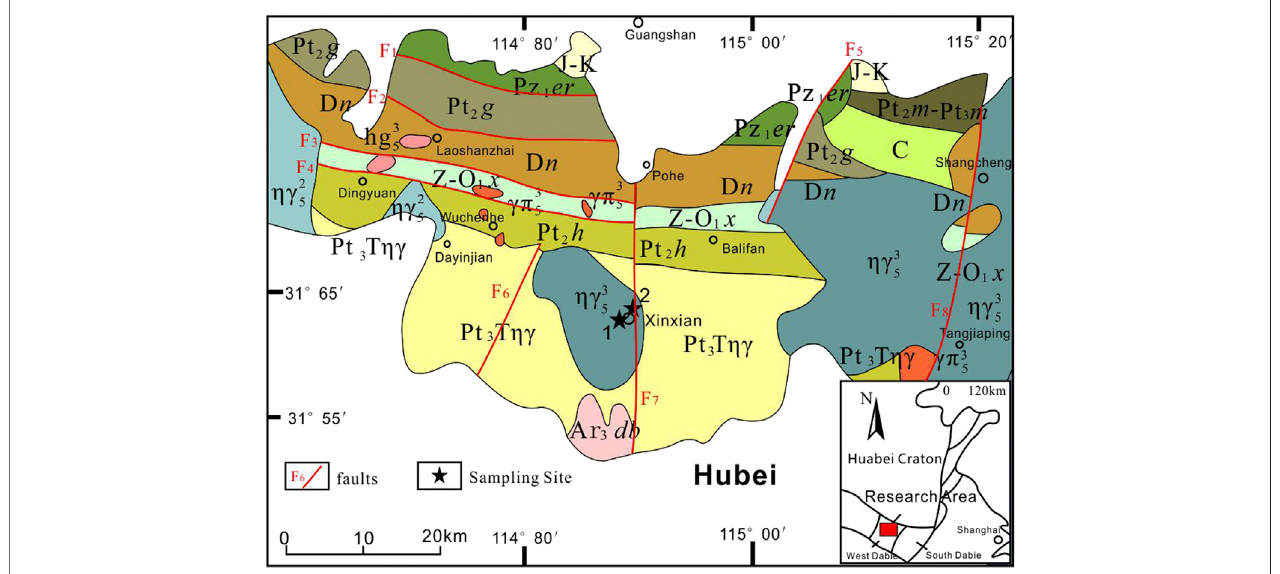
FIGURE1| GeologicalmapoftheXinxianareaintheDabieorogenicbelt(modi fi edafterKun-guangetal.,2009;Dong-xingetal.,2011).J-K,Jurassic – Cretaceous volcanic rocks and volcano-sedimentary rocks; Kc, Lower Cretaceous Chenpeng Formation; D n , Devonian Nanwan Formation; Pz 1 er , Lower Paleozoic Erlangping Group; Z-O 1 , Sinian – Lower Ordovician Xiaojiamiao Formation-Complex; Pt 2 h , Middle Proterozoic Huwan Formation-Complex; Pt 2 g , Middle Proterozoic Guishan Formation-Complex;Ar 3 db,NeoarcheanDabieFormation-Complex; η c 3 5 ,LateYanshanianmonzoniticgranite; c π 3 5 ,Yanshaniangraniteporphyry; hg 3 5 ,Yanshanian quartz diorite; Pt 3 T η c , Neoproterozoic Tianpu Sequence granite